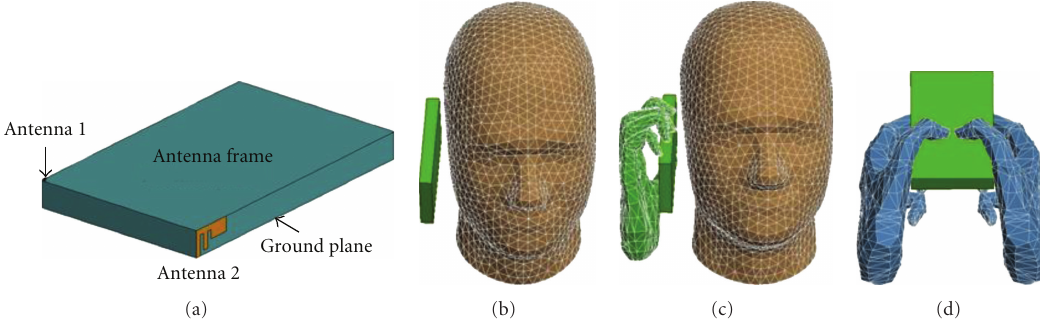
Figure 1: Simulation models for usage scenarios: (a) free space, that is, no user, (b) head and handset in tilt position, (c) voice position (head, hand, and handset in tilt position), (d) data position (two hands and handset).